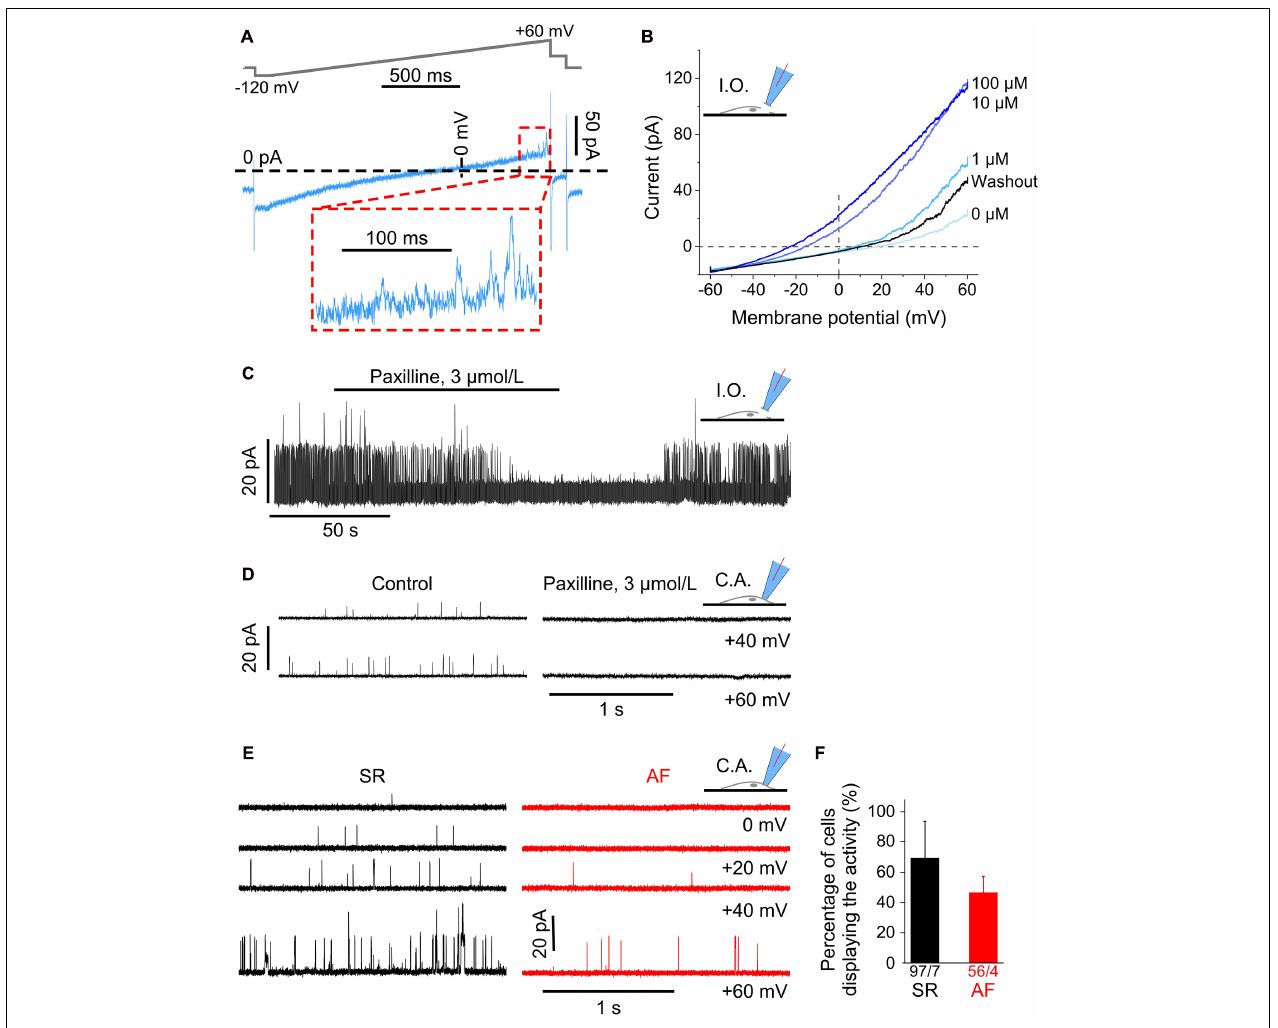
FIGURE 4 | Large Ca 2 + -dependent conductance activated in the positive potential (outward current) range in human atrial fibroblasts. (A) Representative current trace measured with the ramp pulse protocol (whole-cell recording, ruptured patch mode). The inset shows the final 200 ms of the trace (outward current) at positive potentials; the current displays clear single channel openings. (B) Voltage-dependent current amplitude at different intracellular Ca 2 + concentrations (from 0 to 0.1 mM), and after returning to nominally Ca 2 + -free solution (washout). Recordings obtained in inside-out configuration (I.O.). (C) Channel activity in an inside-out patch transiently superfused with paxilline-containing solution. Note that the paxilline-induced inhibition of channel activity was partially reversed during wash-out. (D) Single channel activity in cell-attached patches without (control) and with 3 µ mol L − 1 paxilline in the pipette solution. (E) Single channel events during representative current traces at various holding potentials (cell-attached patch mode) in a cell from an SR and AF patient. (F) Percentage of cells in relation to all cells studied per patient (see total numbers below the columns) that exhibit single channel openings during the final 200 ms of the ramp protocol.